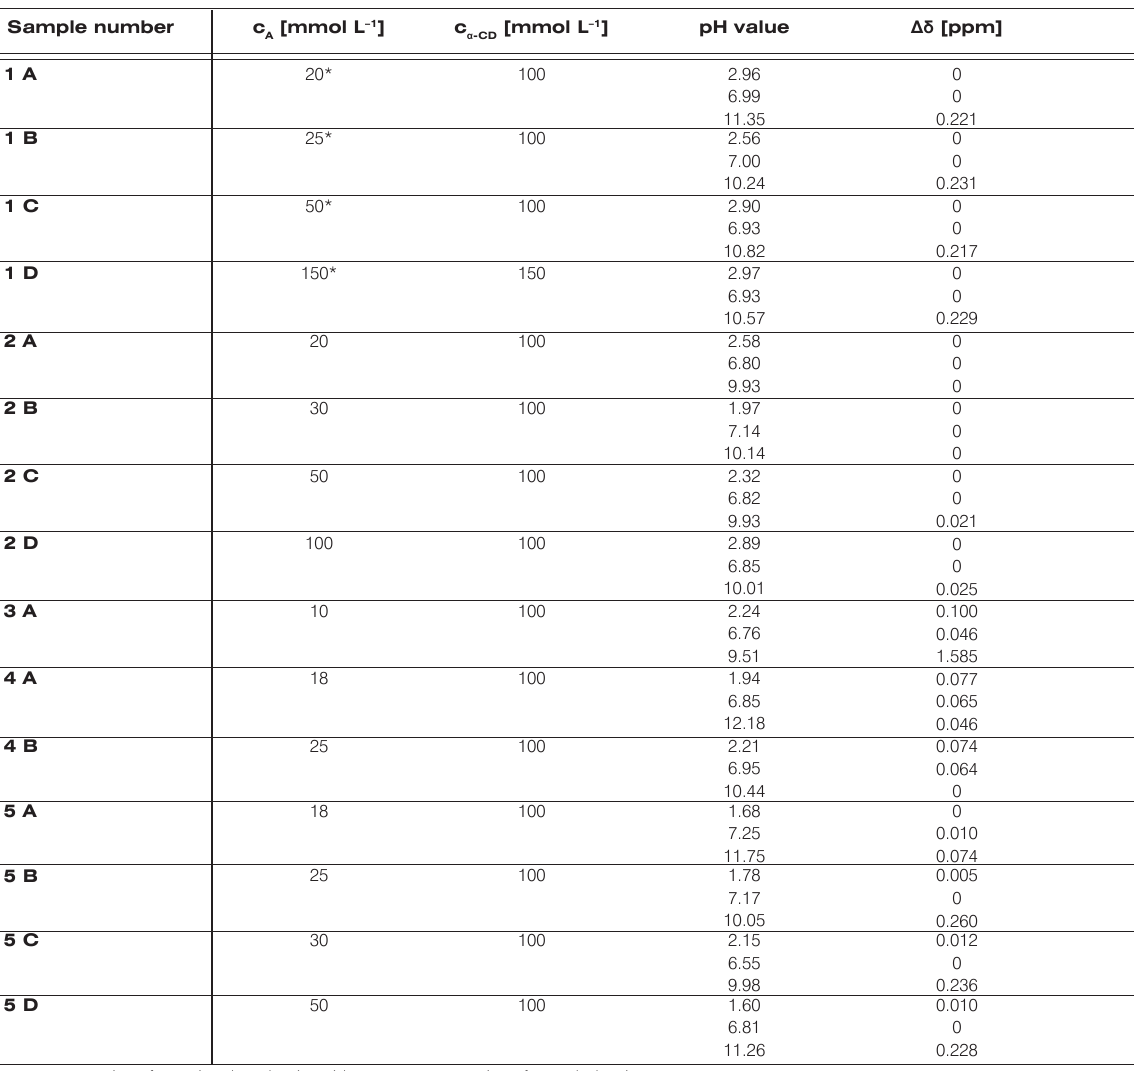
Table 1. Influence of host-guest ratio and pH values on the separation efficiency.